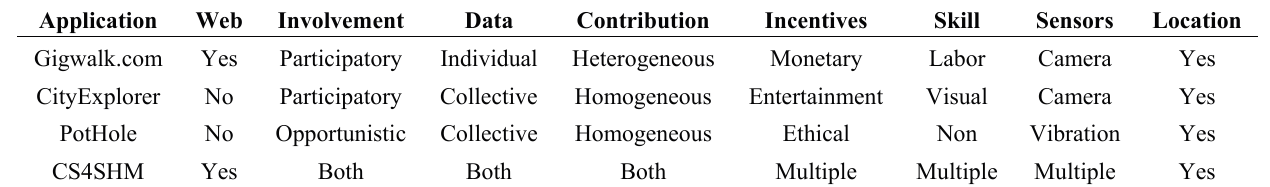
Table 1. Mobile crowdsourcing taxonomy, examples, and crowdsourcing-based SHM [56]. Application Web Involvement Data Contribution Incentives Skill Sensors Location Gigwalk.com Yes Participatory Individual Heterogeneous Visual PotHole Collective Homogeneous Both Multiple Multiple Multiple